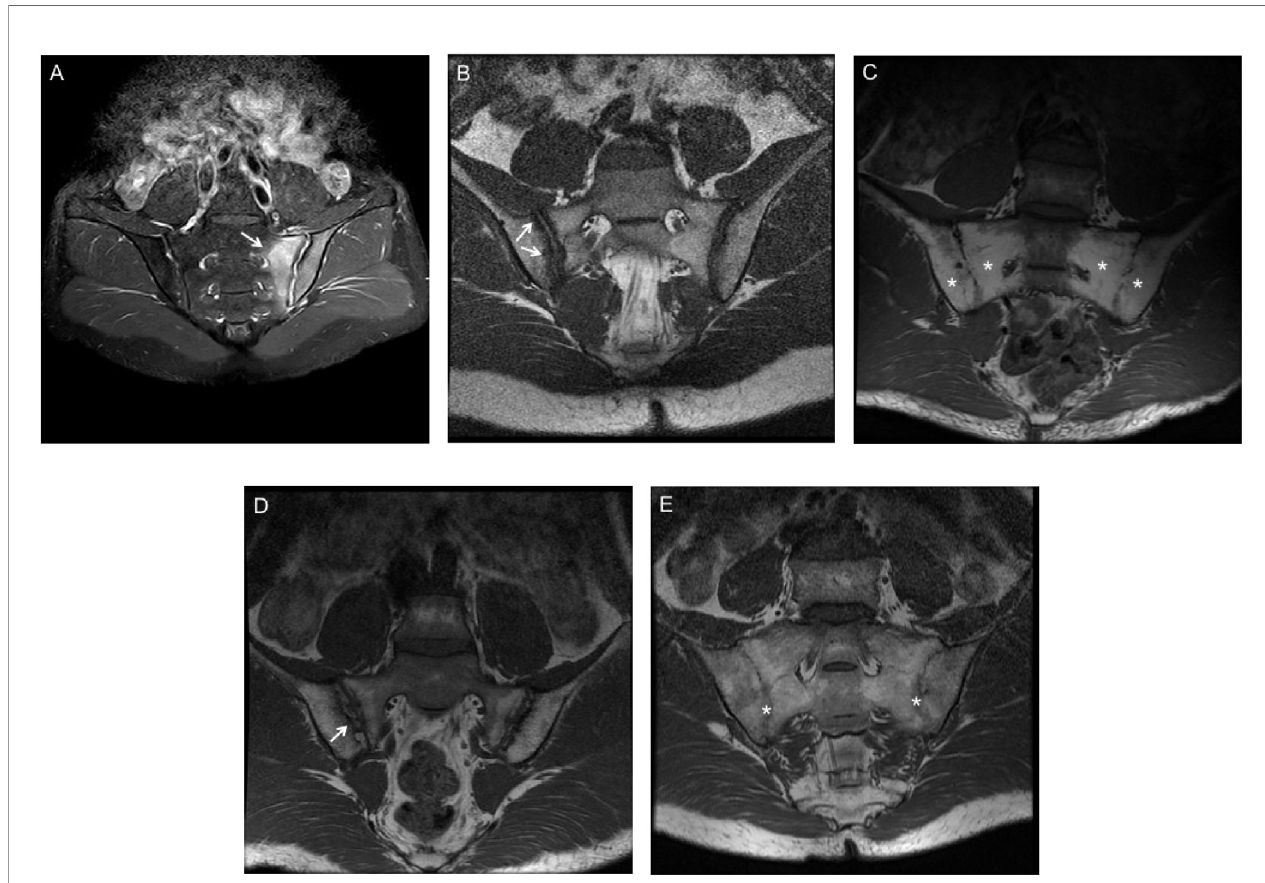
FIGURE 1 | MRI fi ndings of in fl ammatory and structural damage of SpA. (A) Bone marrow edema (BME) at the left side of sacroiliac joints (white arrows) in Coronal oblique STIR sequence. (B) Erosion of the right iliac bone on T1 weighted spin echo MRI (white arrows). (C) Fat metaplasia at the bilateral sacroiliac joints on T1 weighted spin echo MRI (white stars). (D) Back fi ll of the right iliac bone on T1 weighted spin echo MRI (white arrows). (E) Ankylosis of the bilateral sacroiliac joints on T1 weighted spin echo MRI (white